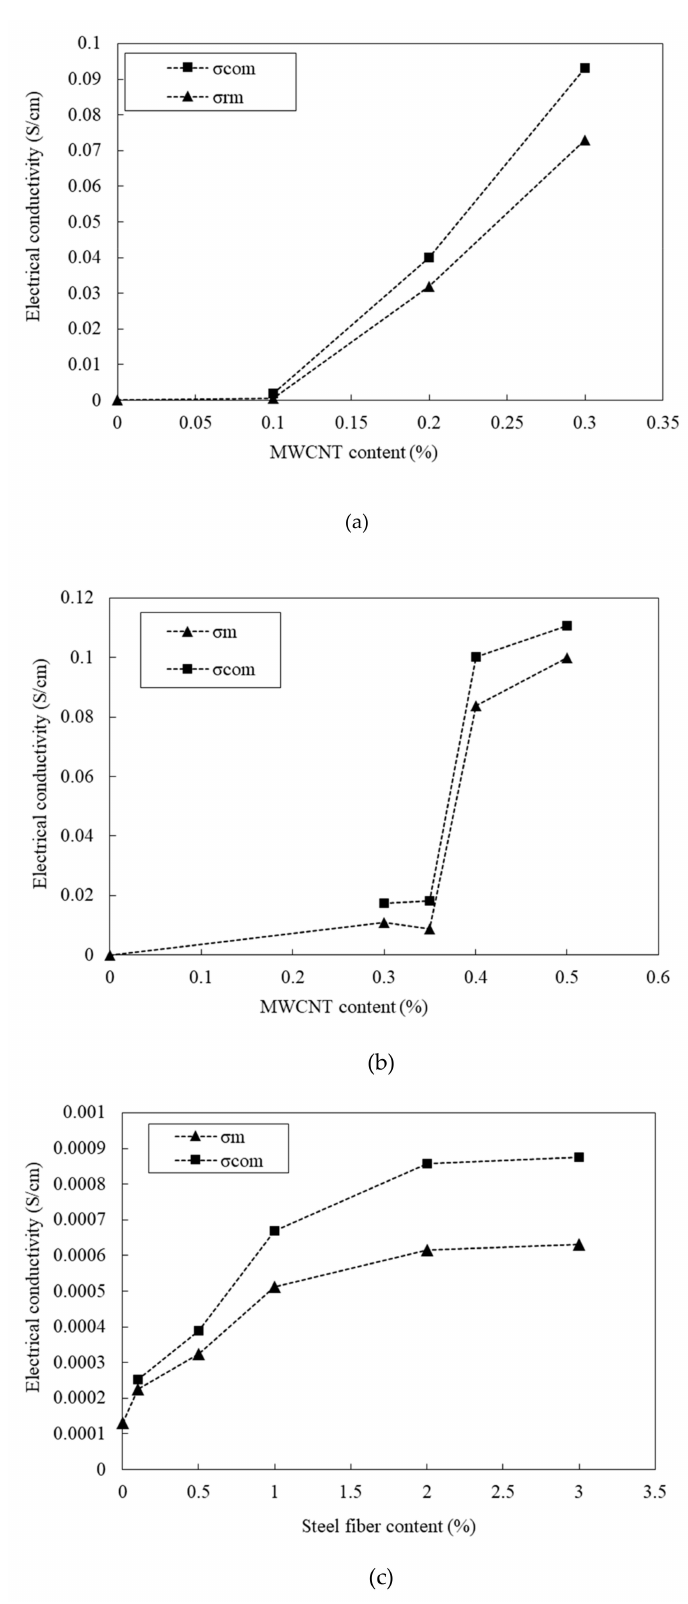
Figure 12. Electrical conductivity of 100 MPa and 180 MPa-HPFRCC w / wo MWCNT and / or steel fiber. ( a ) 100 MPa-HPFRCC without steel fiber; ( b ) 180 MPa-HPFRCC with steel fiber; ( c ) 100 MPa-HPFRCC with steel